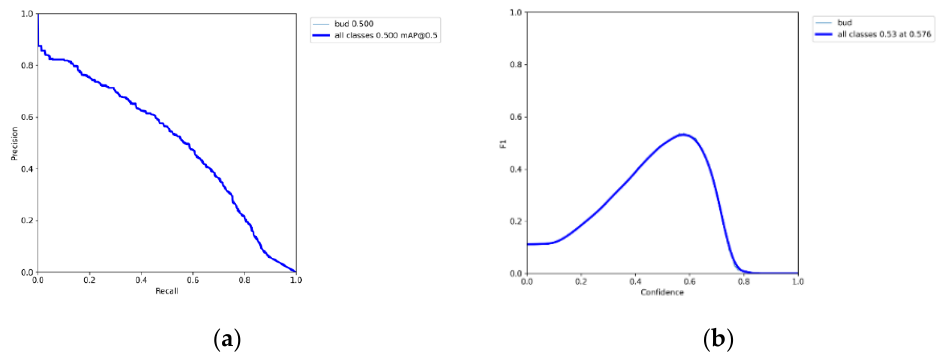
Figure A4. The changes of recall of YOLOV5s.